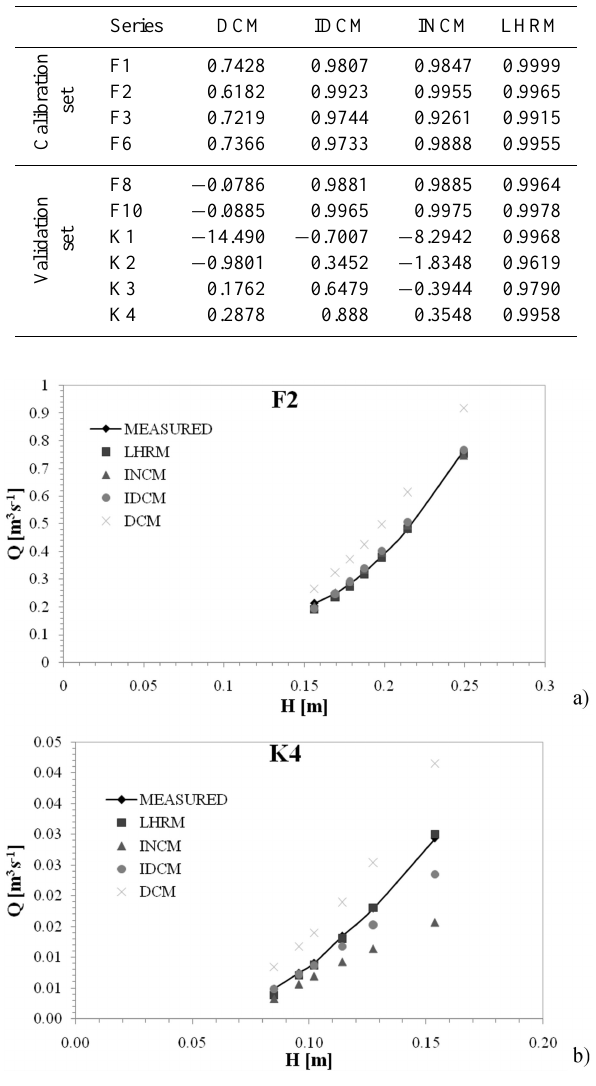
Figure 3. Estimated discharge values against HR Wallingford FCF measures for F2 (a) and K4 (b)